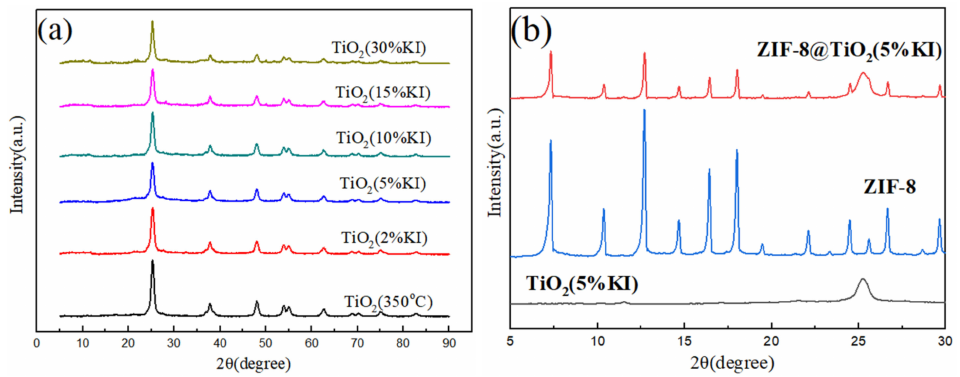
Figure 1. ( a ) XRD patterns of TiO 2 doped with different amounts of I, ( b ) XRD patterns of TiO